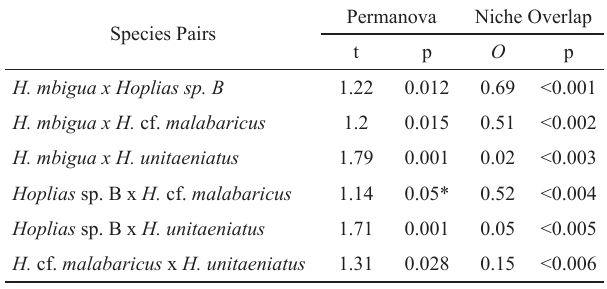
Tab. 5. PERMANOVA (t - pairwise comparison) post hoc test results applied to species diet and Pianka’s niche overlap ( O ) between non-native ( H. mbigua and H. unitaeniatus ) and native ( Hoplias sp. B and H. cf. malabaricus ) Erythrinidae species in the upper Paraná River floodplain. *Considered significant.